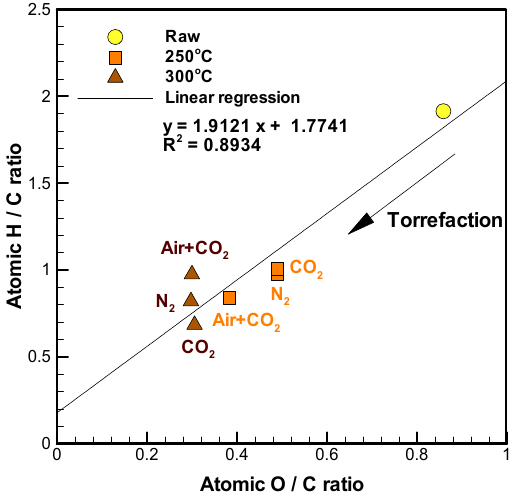
Figure 5. Profiles of atomic H/C ratio vs . O/C ratio of raw and torrefied corncob